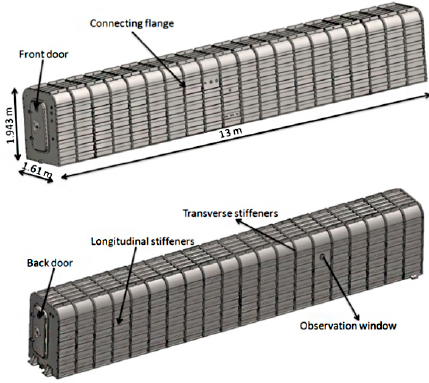
Figure 1. Schematic diagram of the refuge chamber model. Table 1. Design parameters used in the refuge chamber.